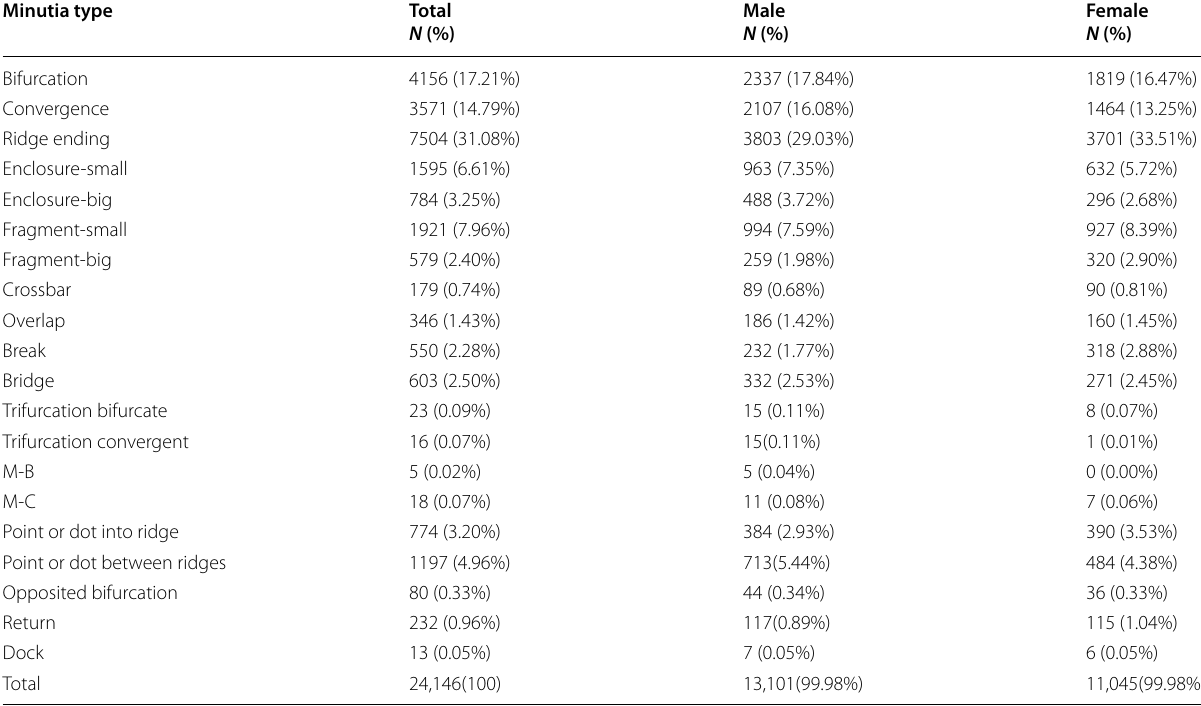
Table 1 Frequency distribution of different types of minutiae in the thumbprint of males and females Minutia